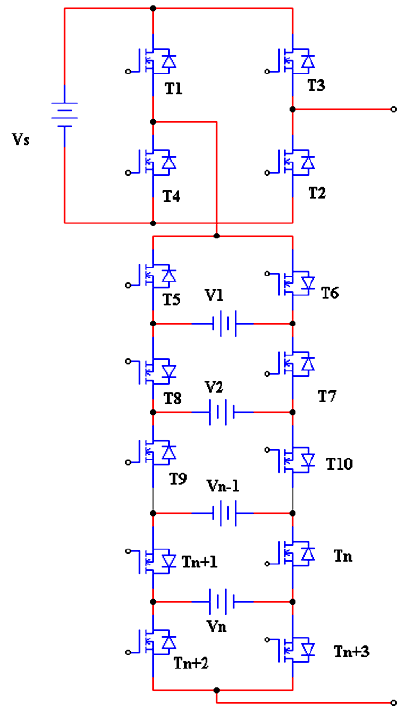
Figure 49. Reverse connected voltage source MLI.